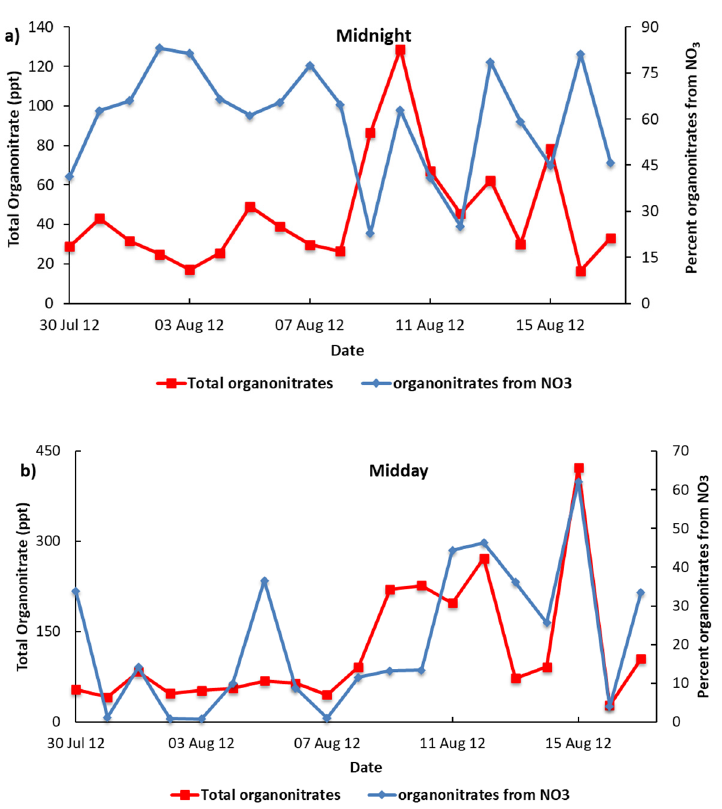
Figure 2. Total organo-nitrate and contributions sourced from NO 3 ( a ) midnight and ( b ) midday in North Kensington during summer months.